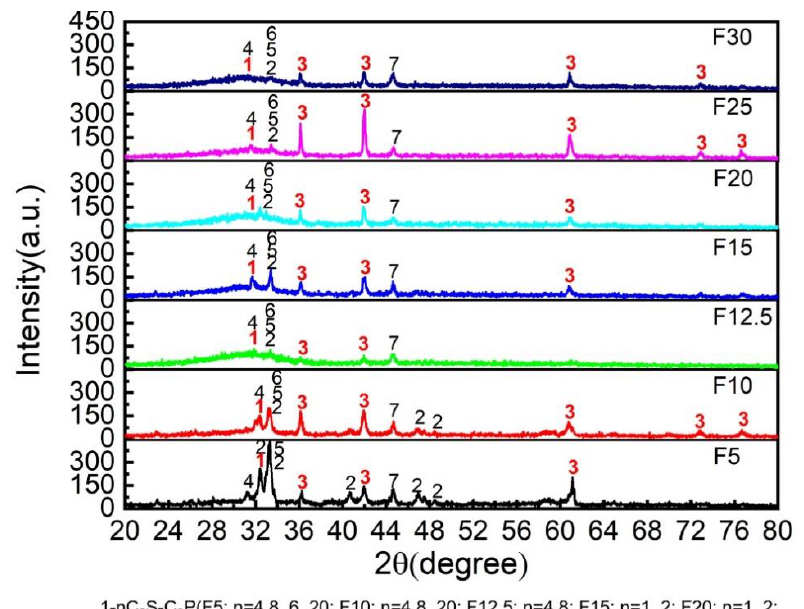
Figure 9. XRD analysis results of dephosphorization slags for the samples from F5 to F30.